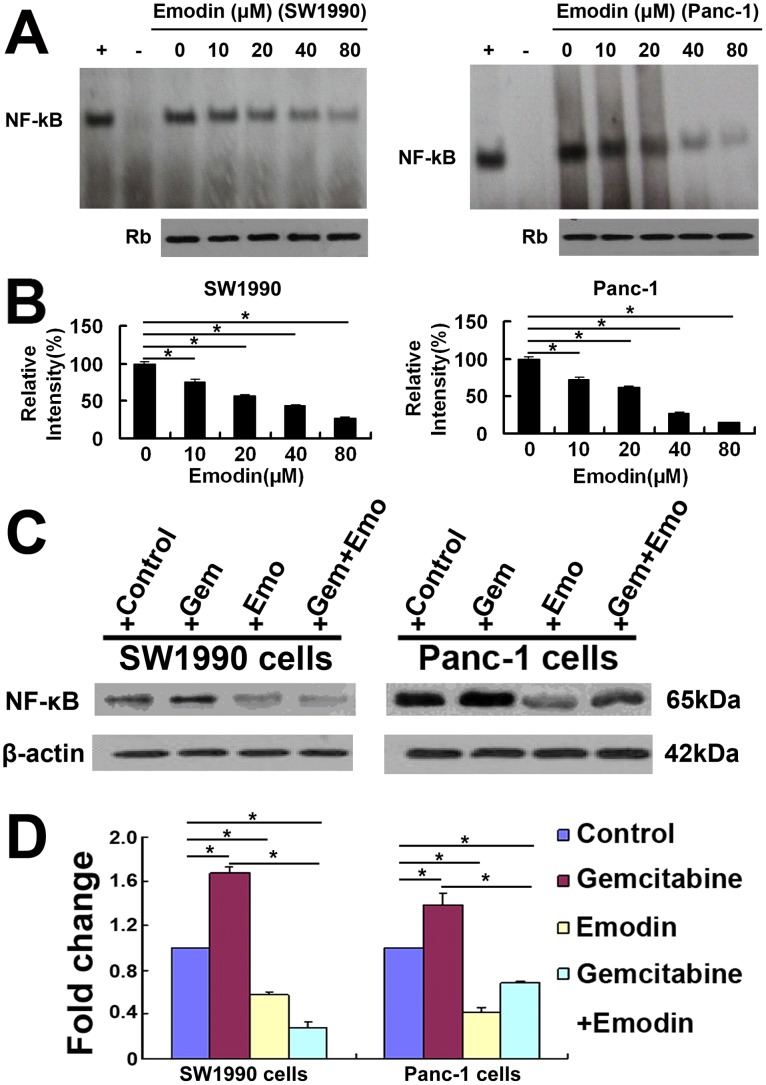
Effect of emodin on the spontaneous and gemcitabine-induced activation of NF-κB in vitro.(A) Representative images showing that the treatment with emodin for 72 h inhibited the activity of NF-κB in a dose-dependent manner in SW1990 cells and Panc-1 cells. (B) Data are expressed as mean%±SD of the relative levels of NF-κB activation in SW1990 cells and Panc-1 cells from tree separate experiments. Equal protein loading was ensured by immunoblotting 10 µg of nuclear protein with anti-retinoblastoma antibody. The nuclear extracts from unstimulated gastric cancer SGC7901 cells were used as negative control, and SGC7901 cells stimulated with 50 ng/mL TNFα were used as positive control. +: positive control; –: negative control. (C) Emodin attenuated the spontaneous and gemcitabine-induced NF-κB expression in SW1990 cells and Panc-1 cells. (D) Quantification was performed by calculating the ratio of the value to the control group. *, P<0.05.